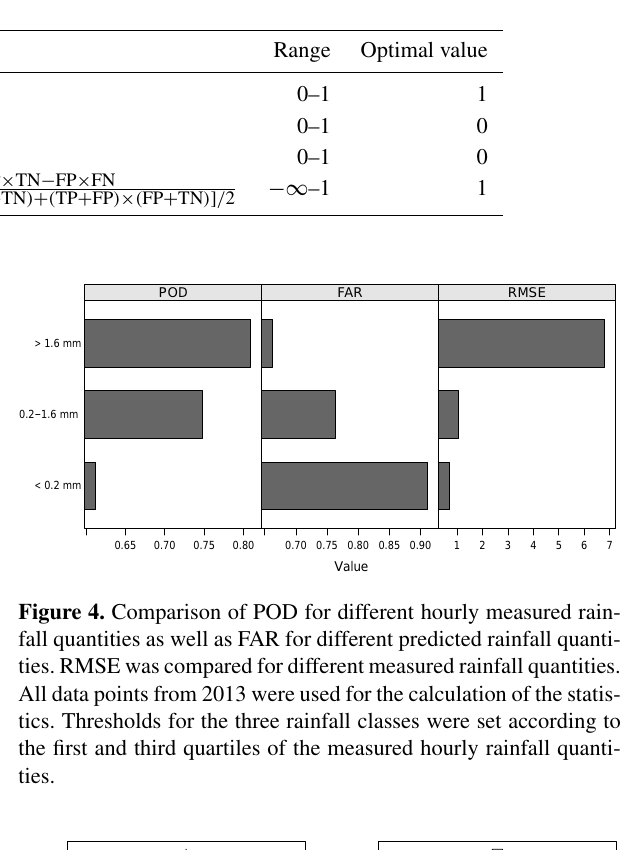
Table 3. Categorical metrics for validation of rainfall area estimates.